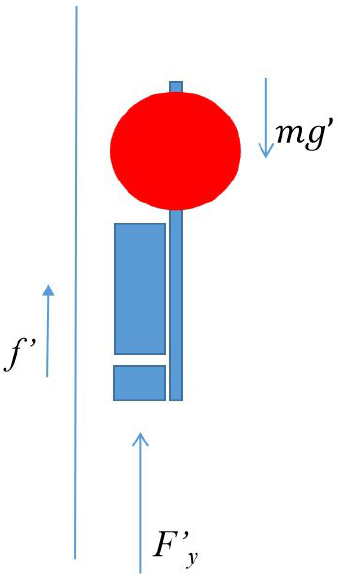
Figure 23. Profile AUV stress in the vertical direction during descent .